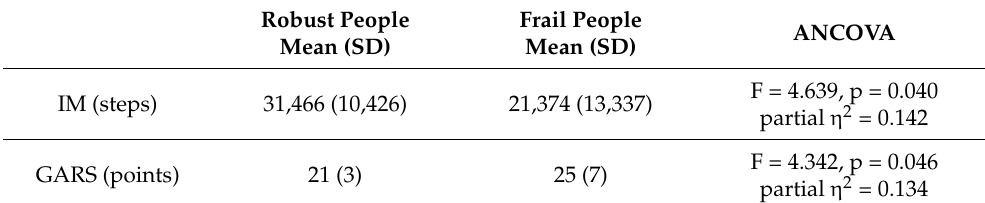
Table 2. ANCOVA outcomes.